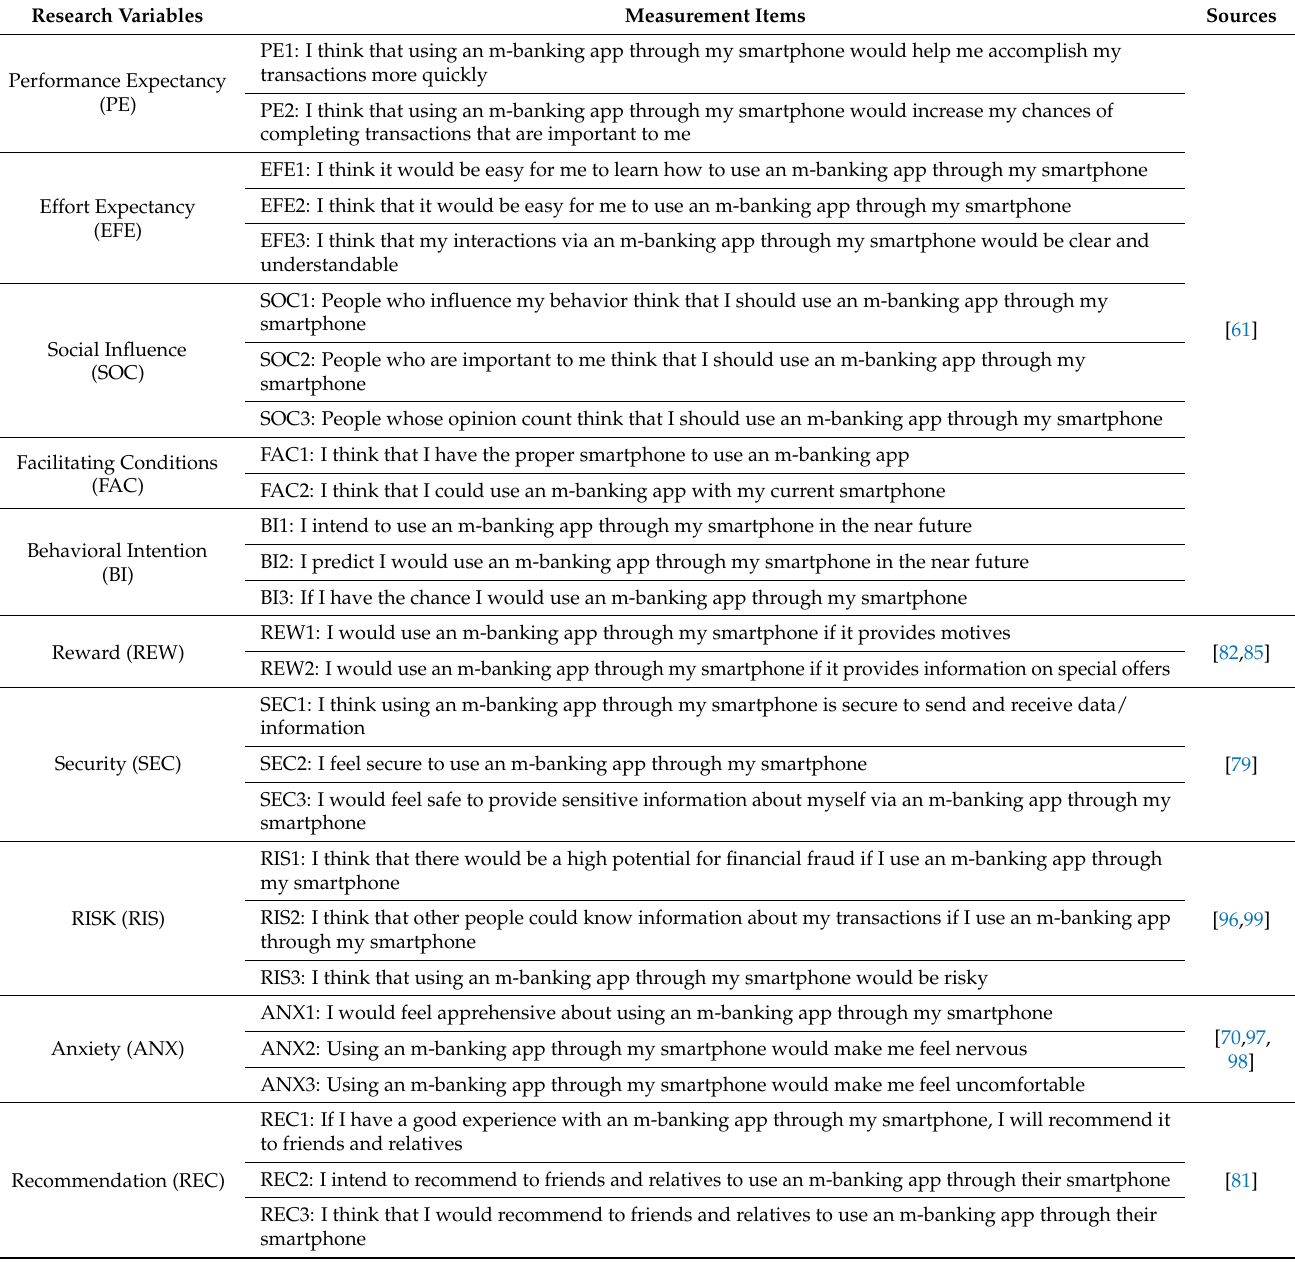
Table 1. Questionnaire of the